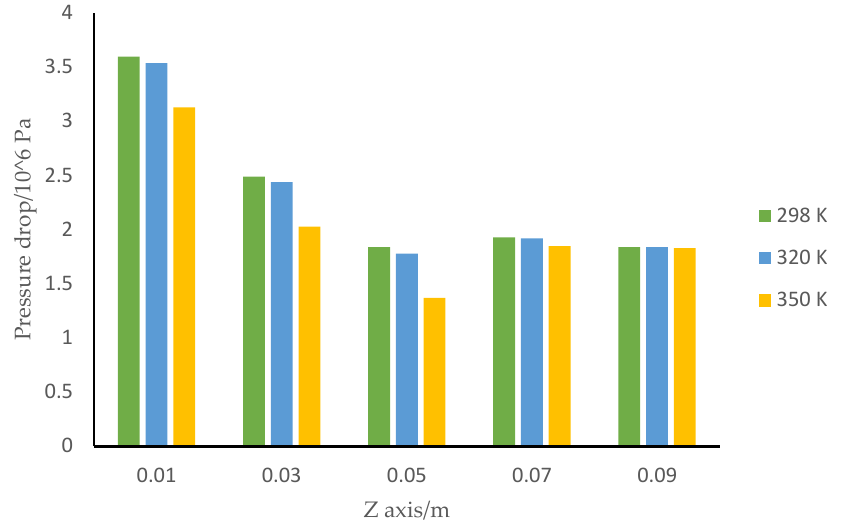
Figure 6. Pressure difference distribution of liquid water at three different temperatures in the Zwart isothermal cavitation model.